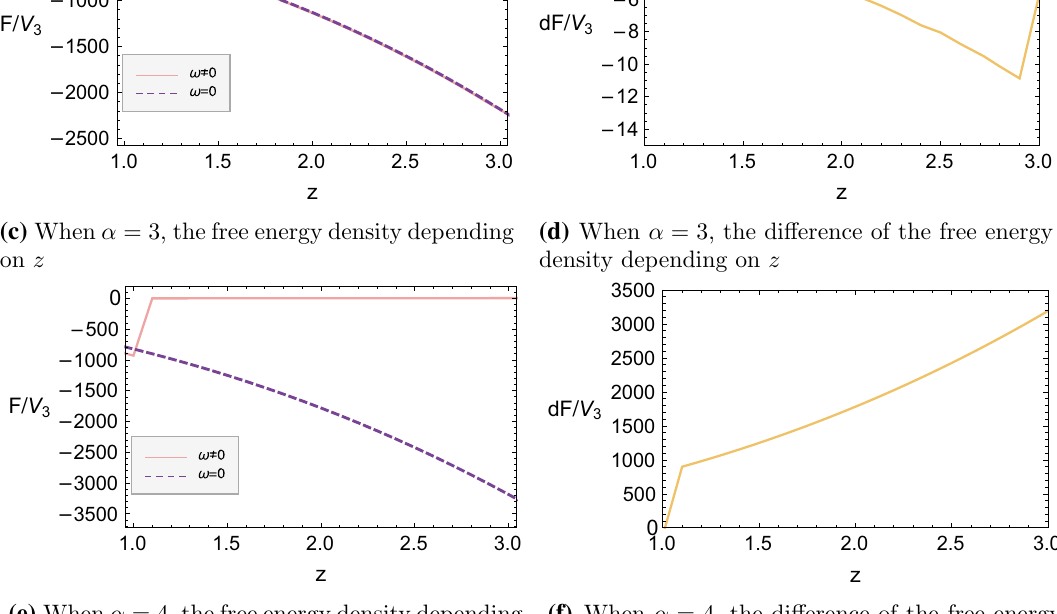
Fig. 6 For fixed value of α . The free energy densities for the anisotropic and isotropic phase (left), and the free energy density difference between two phases (right) depending on z . Respectively, a , b α = 0 , 1 , 2 (from top to bottom on the right axis), c , d α = 3, e , f α = 4